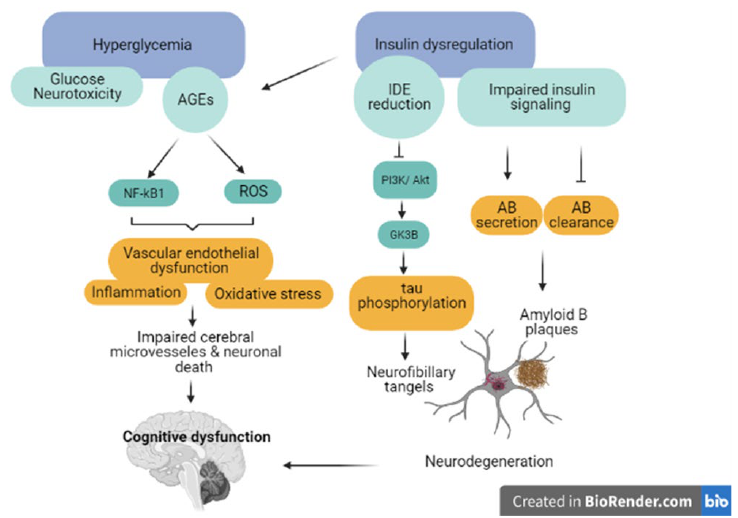
Figure 2. The potential mechanisms linking type 2 diabetes mellitus-related changes with cognitive decline and dementia progression. Abbreviations: AGEs: advanced glycation end products, ROS: reactive oxygen species, IDE: insulin degradation enzymes, AB: amyloid β.